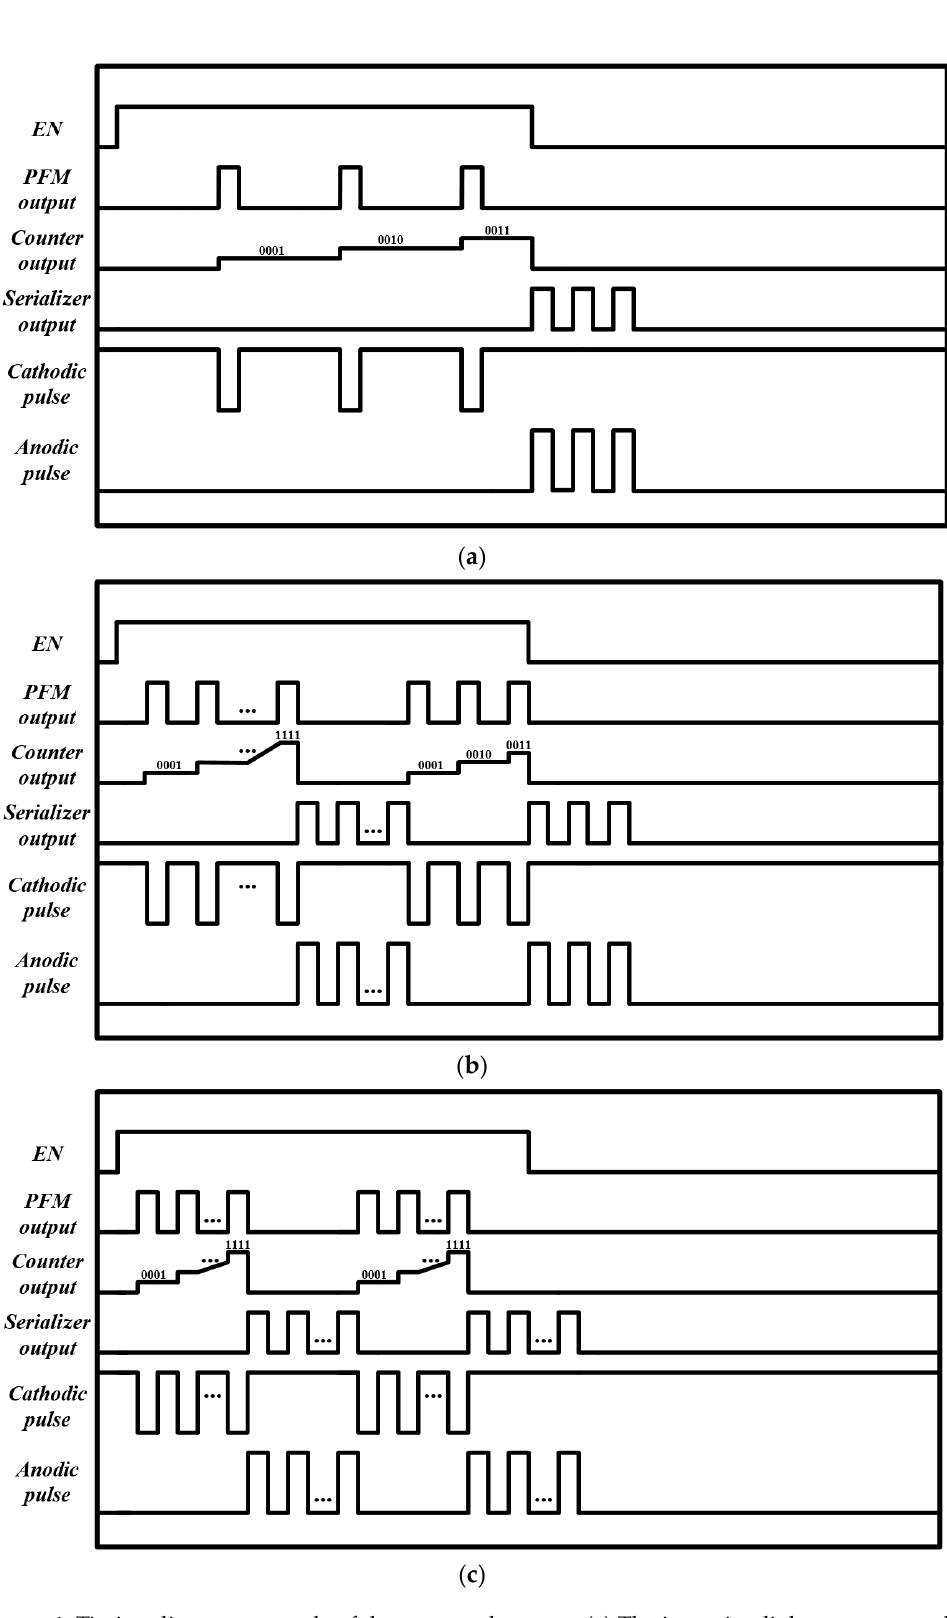
Figure 4. Timing diagram example of the proposed system. ( a ) The incoming light generates only three pulses. ( b , c ) The incoming light generates pulse that is composed of more than 16 pulses during enable high.